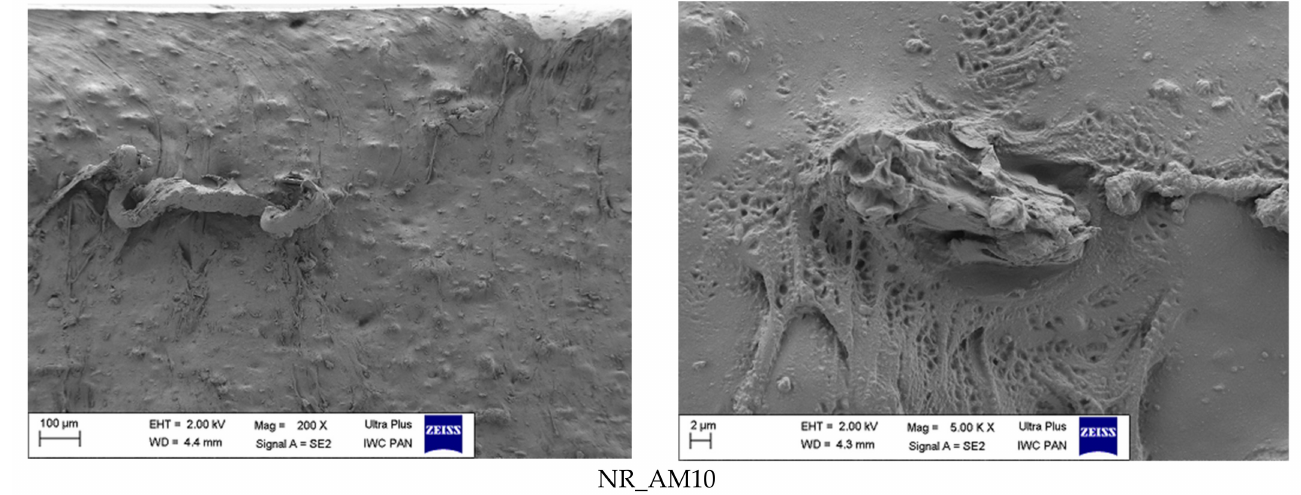
Figure 10. SEM images of biocomposites at the 200 × and 5000 × magnification.